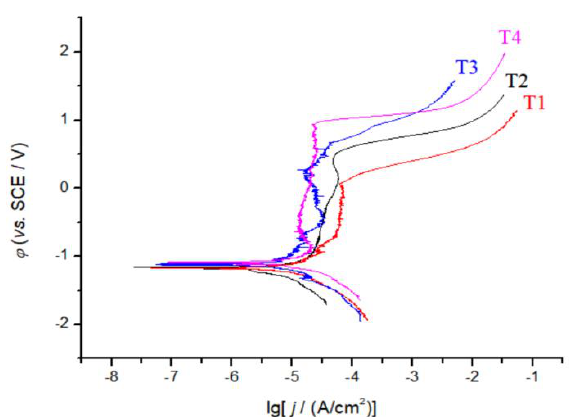
Figure 7. Polarization curves of CoCrFeNiTi x high entropy alloy coatings, where x = 0.1, 0.3, 0.5, or 0.7, and are abbreviated as T1, T2, T3, or T4, respectively, in 3.5 wt.% NaCl solution. Table 3. Electrochemical parameters of different HEAs in 3.5 wt.% NaCl solution.